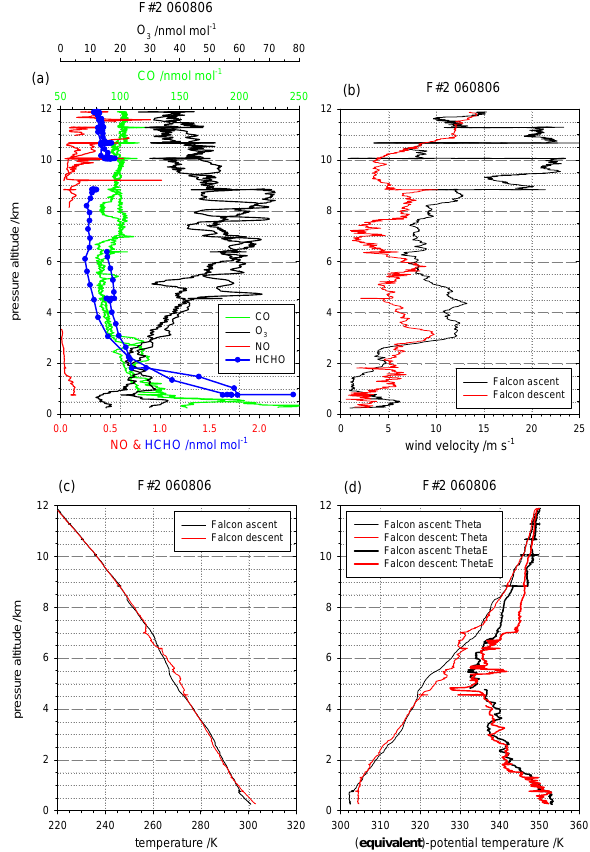
Fig. 5. Vertical profiles for CO, O 3 , HCHO, and NO (a) , wind velocity (b) , temperature (c) , and (equivalent)-potential temperature (d) derived from Falcon measurements on 6 August